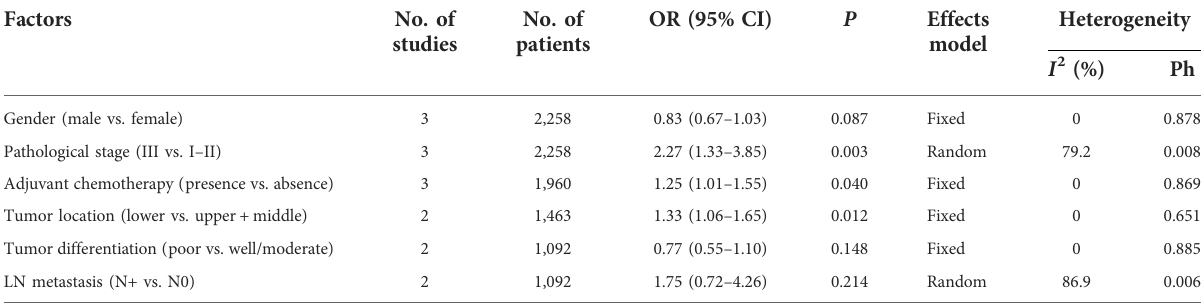
TABLE 3 The association between GNRI and clinicopathological features in patients with gastric cancer.